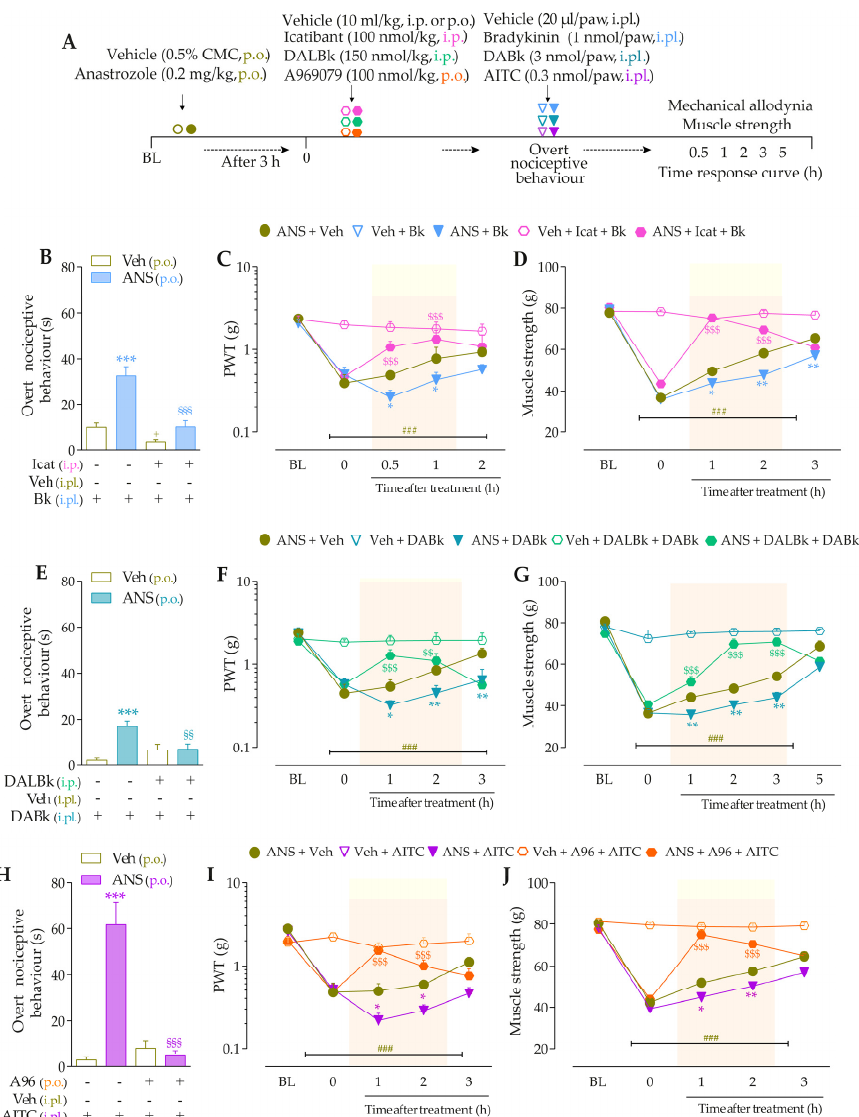
Figure 3. The development of nociceptive behaviors induced by anastrozole is dependent on B 2 and B 1 receptors and the TRPA1 channel in mice. ( A ) Male C57BL/6 mice were treated by the oral route (p.o.) with anastrozole (0.2 mg/kg) or its vehicle (0.5% CMC) to induce painful behaviors. At 3 h after anastrozole administration (Time 0), the animals received a single administration of vehicle (10 mL/kg, intraperitoneal, i.p., or p.o.), Icatibant (100 nmol/kg, i.p.), DALBk (150 nmol/kg, i.p.), or A967079 (100 mg/kg, p.o.). After 0.5 h, vehicle (20 µL/paw, intraplantar, i.pl.) or sub-nociceptive doses of their respective agonists, Bk (1 nmol/paw, i.pl.), DABk (3 nmol/paw, i.pl.), or AITC (0.3 nmol/paw, i.pl.), were injected via the intraplantar route. The overt nociceptive behavior was imme-